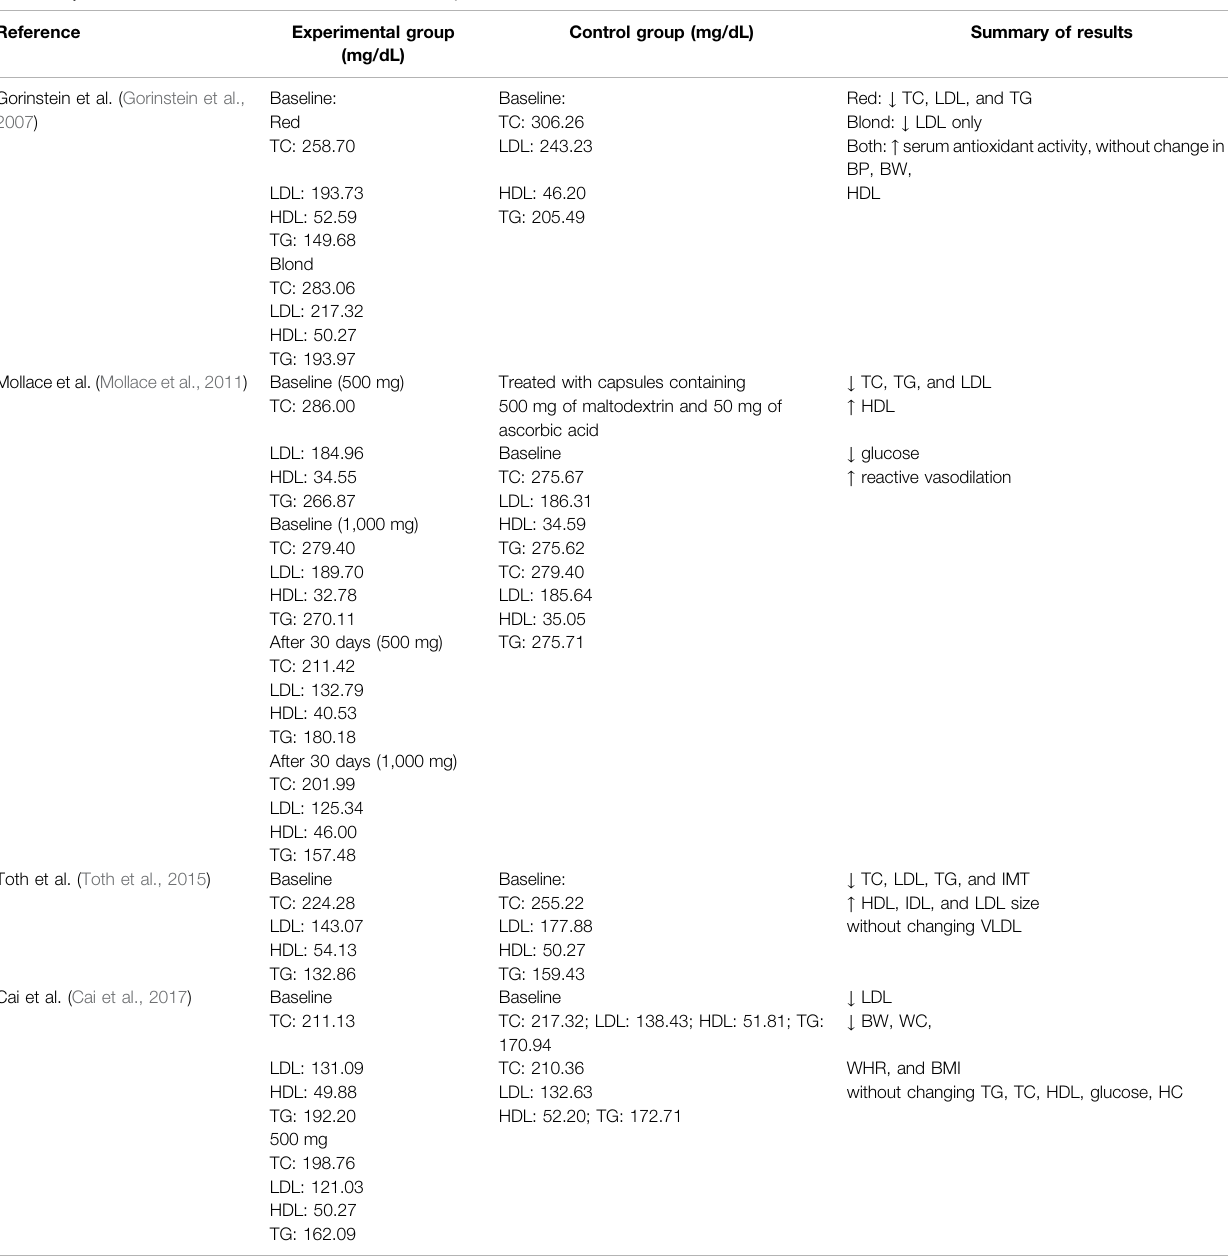
TABLE 4 | Outcomes of the clinical studies included in this systematic review.